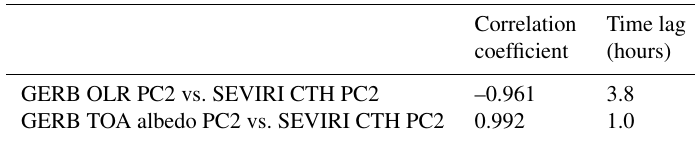
Table 3. Same as Table 1, but for OLR and TOA albedo retrieved from Geostationary Earth Radiation Budget (GERB) observations, and CTH retrieved from Spinning Enhanced Visible and InfraRed Imager (SEVIRI)